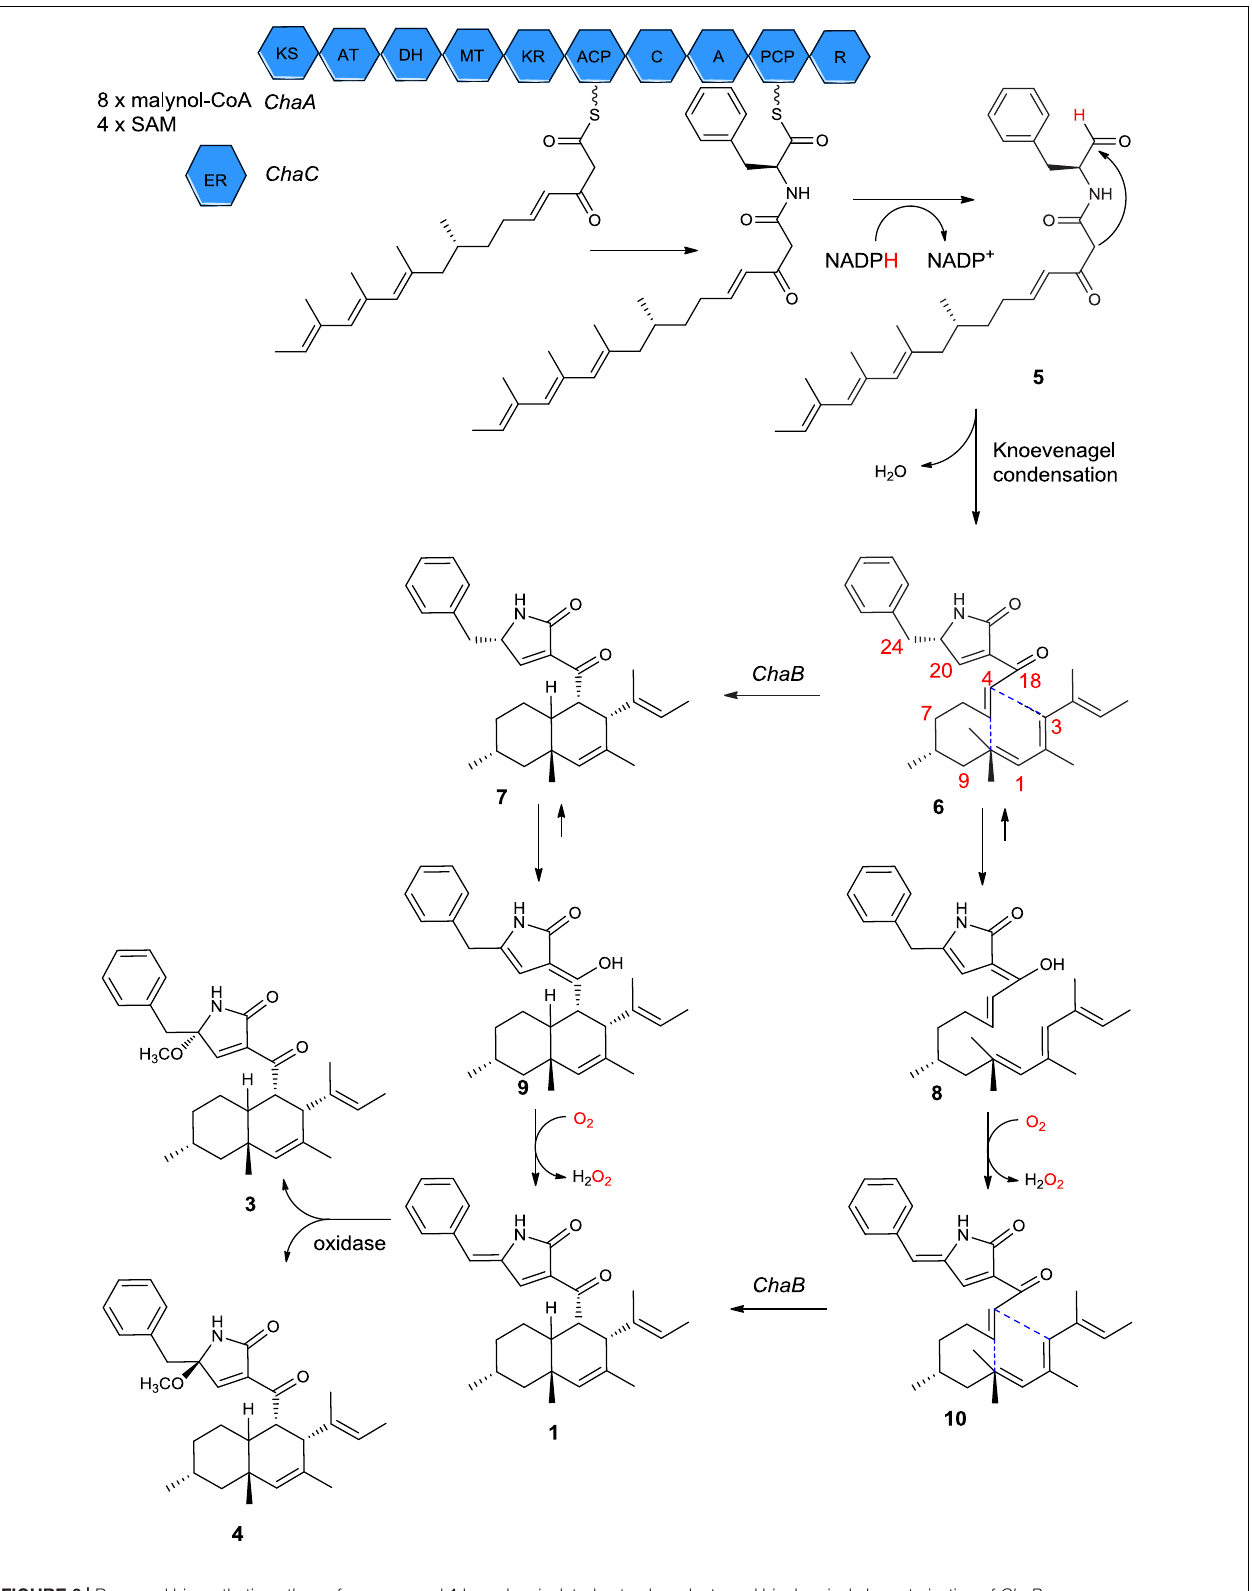
FIGURE 6 | Proposed biosynthetic pathway for compound 1 based on isolated natural products and biochemical characterization of ChaB .